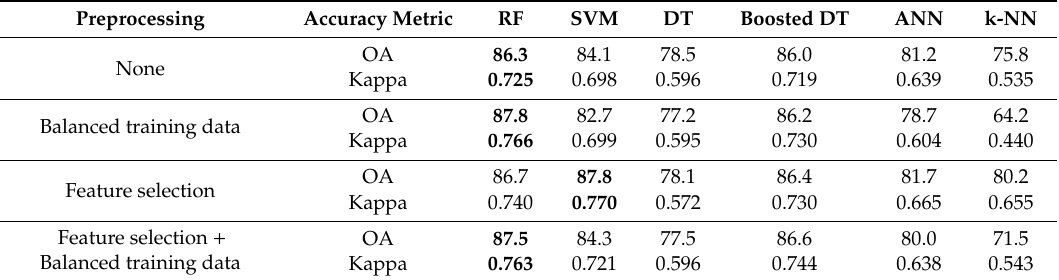
Table 7. OA (%) and Kappa statistic results for each tested classifier and preprocessing scenario. Bold denotes the best accuracies for each preprocessing scenario. The 25% of the labeled samples were used for training and the remaining ones for